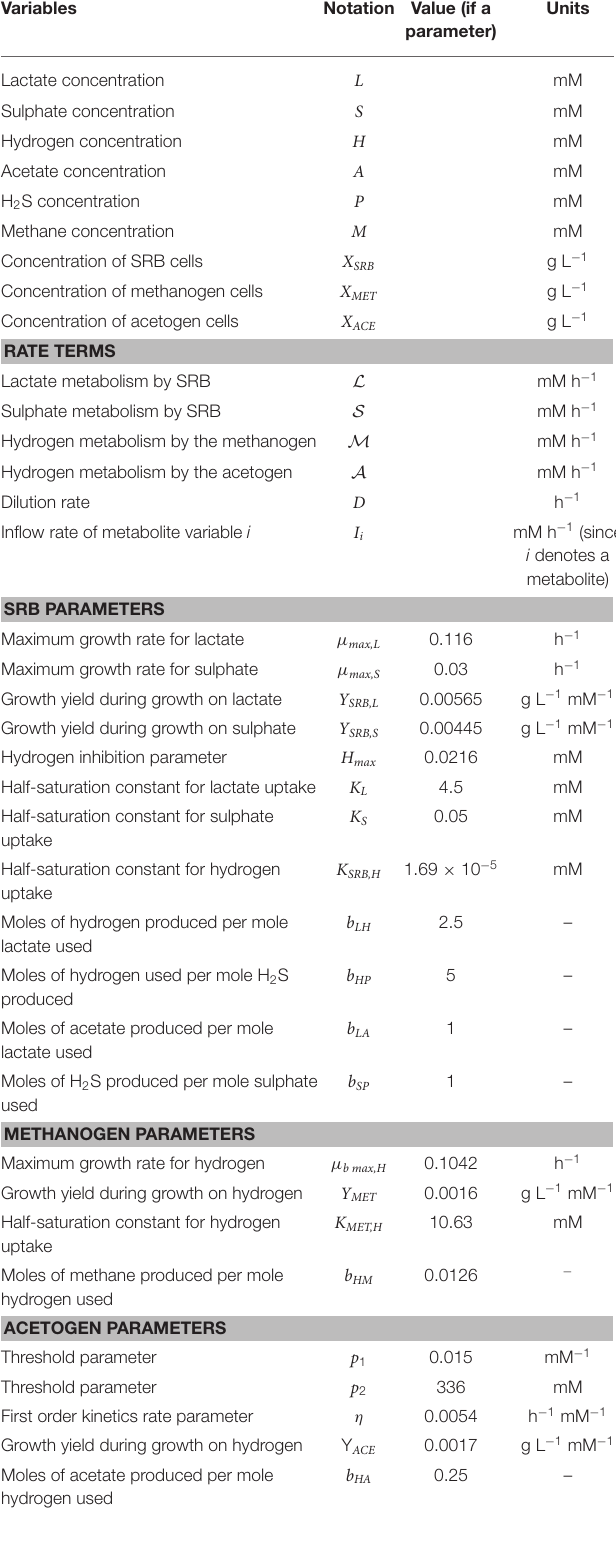
TABLE 1 | Mathematical notation used in the